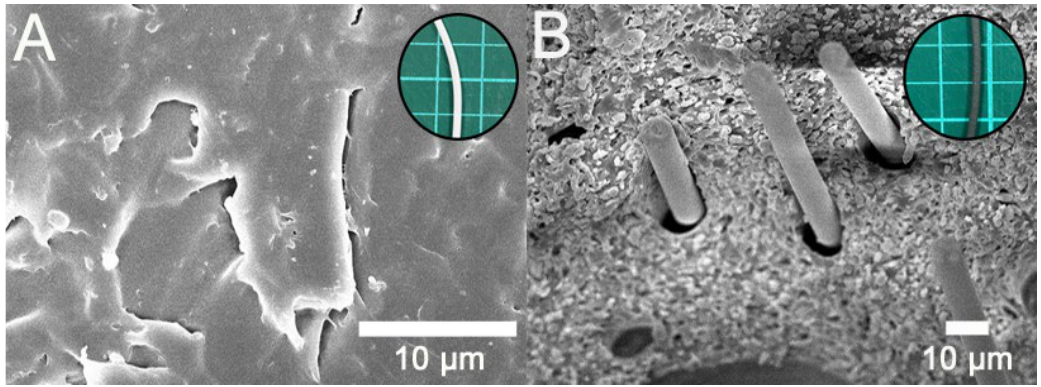
Polymers 2020 , 12 , x Figure 4. Surface images of 3D-printed ( A ) PLA and ( B ) CFR-PLA. Figure 4. Surface images of 3D-printed ( A ) PLA and ( B ) CFR-PLA.